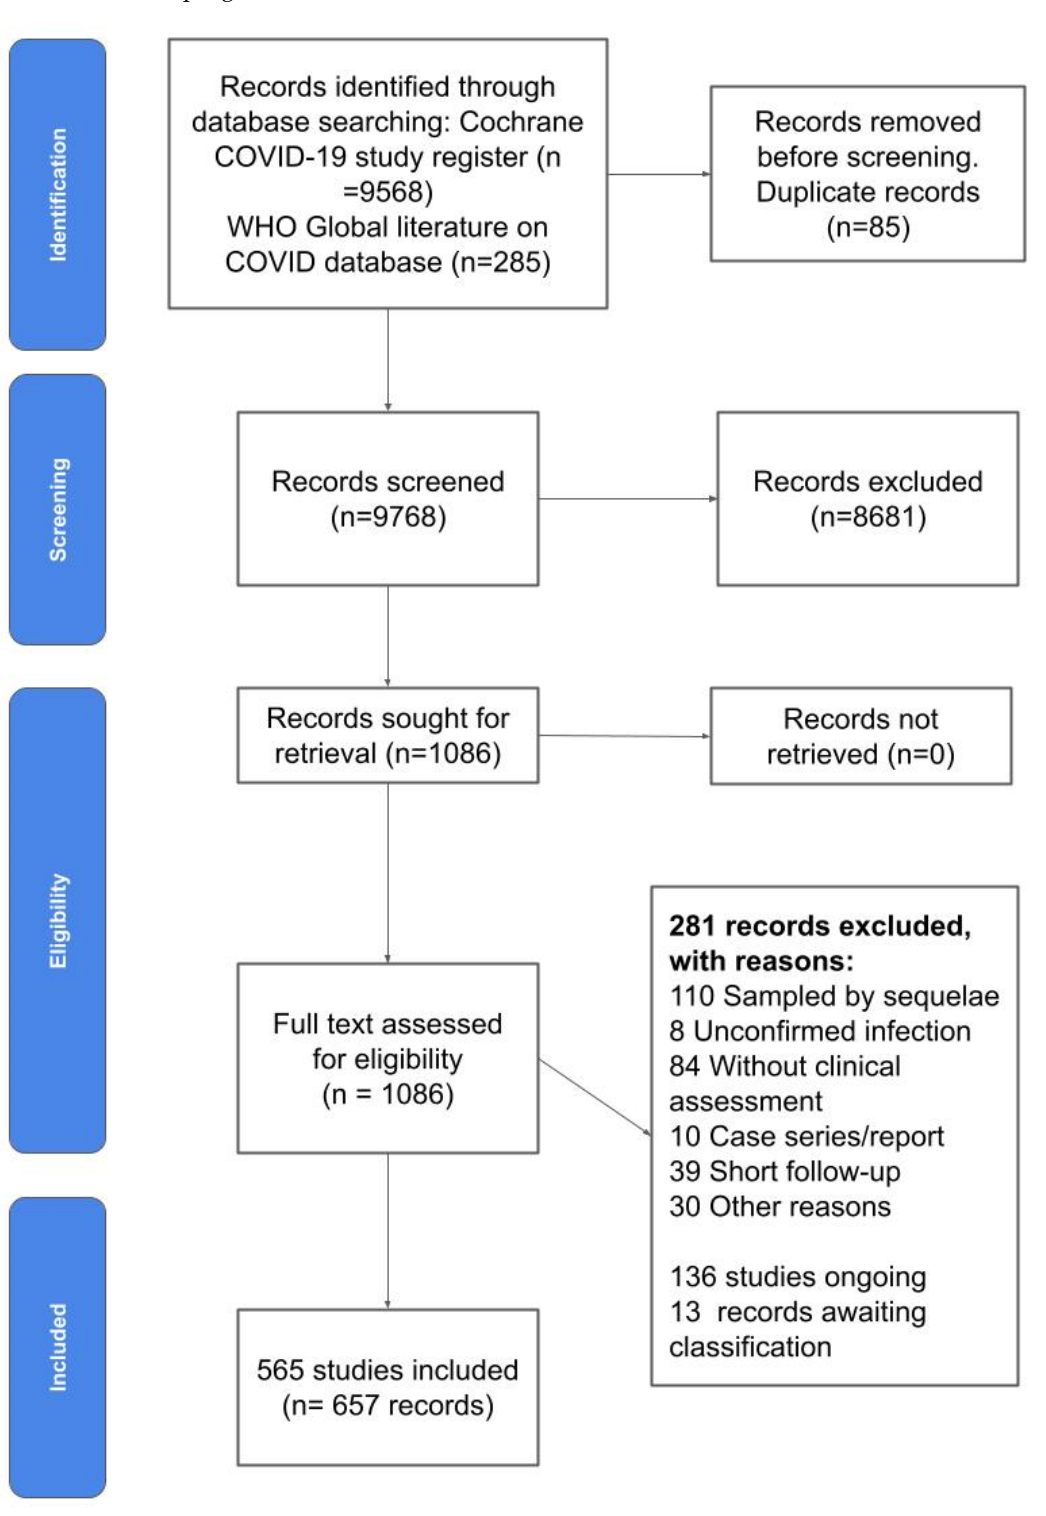
Figure 1. PRISMA Flow diagram.